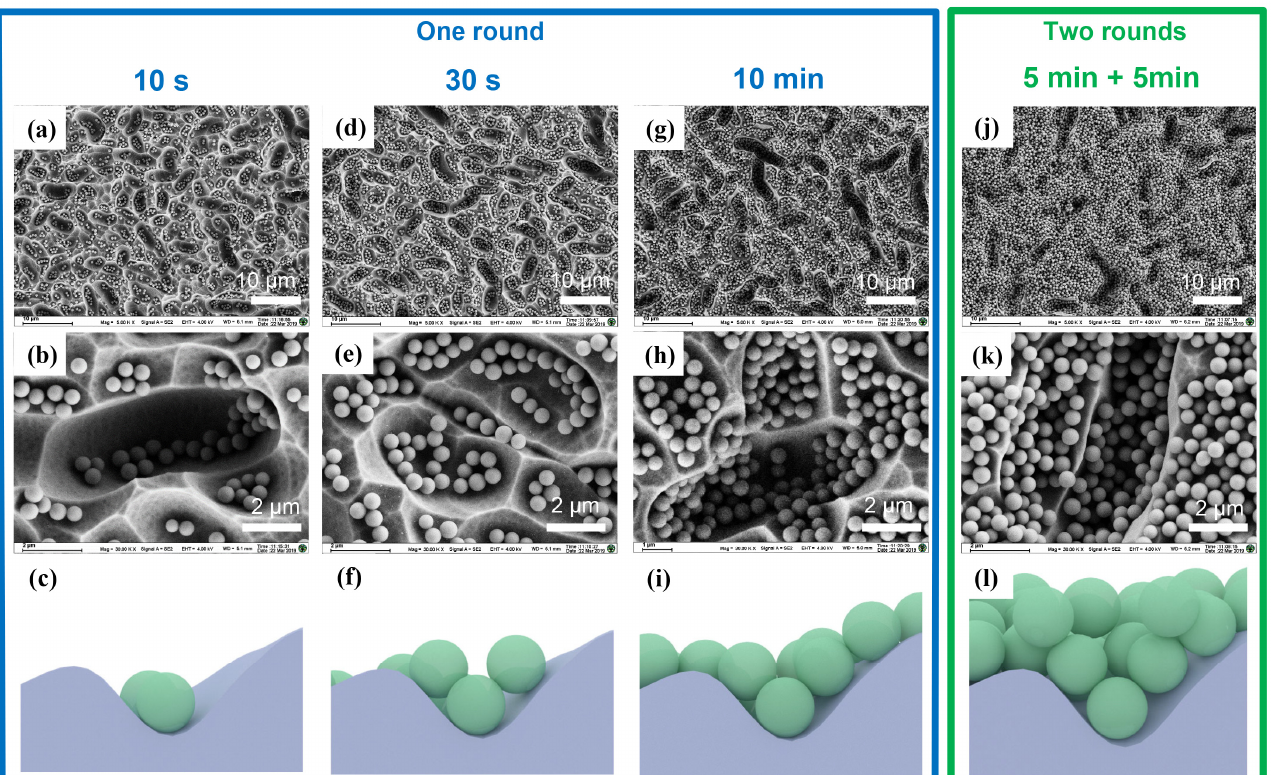
Figure 4. Self-assembly nanocoating under different timelines and repeated assembly process. SEM graphs under different magnification and the schematic diagram: ( a – c ) One round with an assembly time of 10 s; ( d – f ) One round with an assembly time of 30 s; ( g – i ) One round with an assembly time of 10 min; ( j – l ) Two rounds with assembly times of 5 min + 5 min.